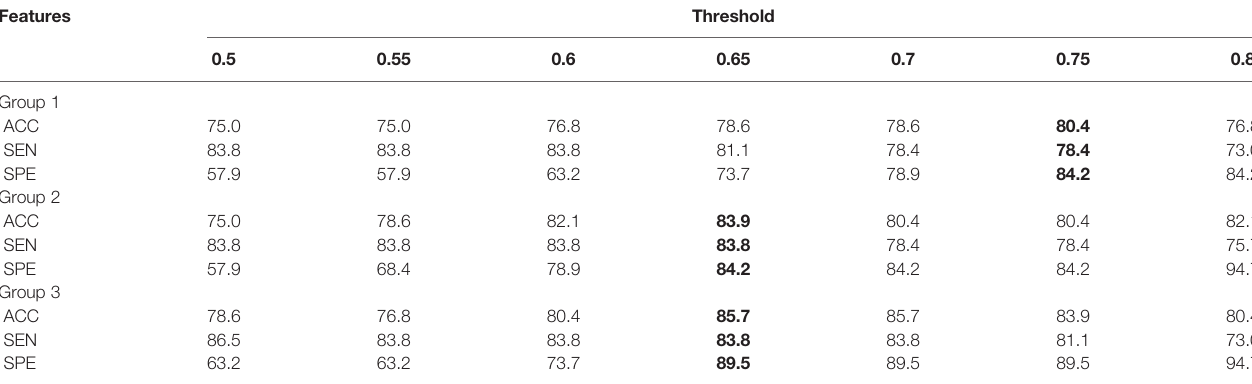
TABLE 4 | Validation results based on plain phase as the threshold varied: accuracy (ACC, %), sensitivity (SEN, %), and speci fi city (SPE, %).